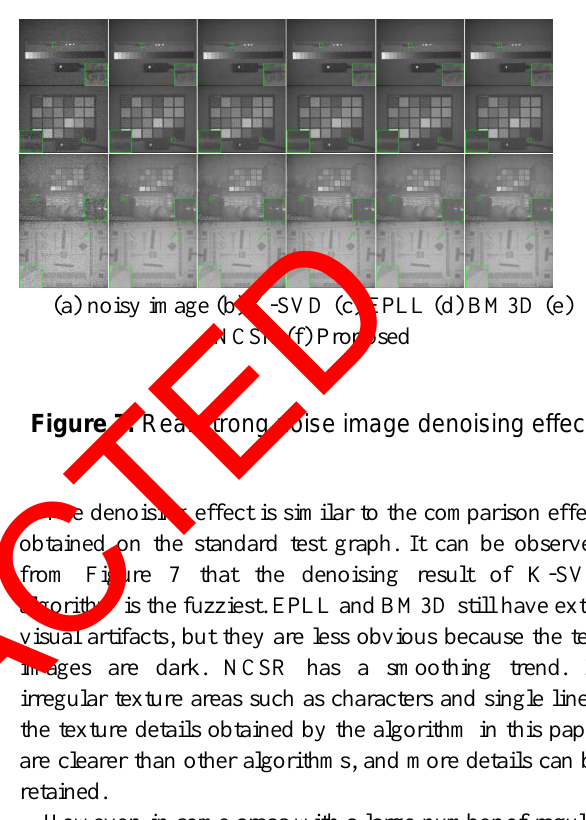
Figure 6. Reference image used in real noise image denoising